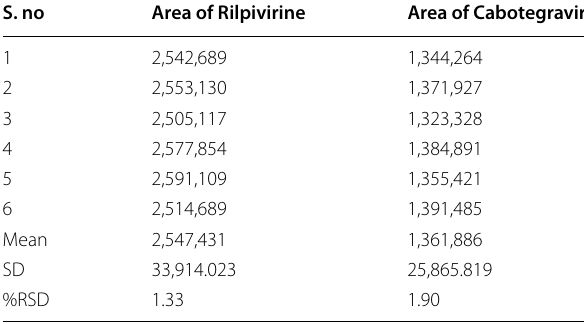
Table 5 Results of method precision